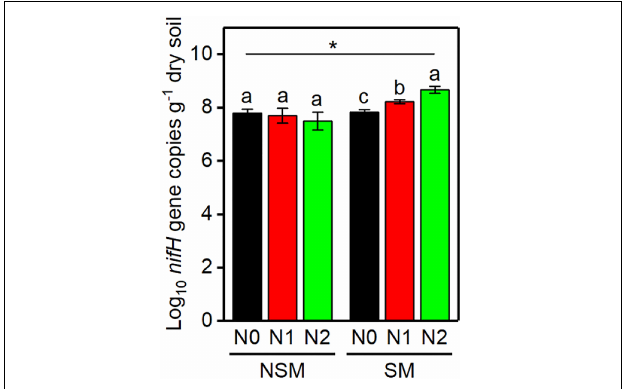
FIGURE 1 | The abundance of nifH gene copies in wheat rhizosphere soil under straw mulching and nitrogen fertilization treatments. NSM, no straw mulching; SM, straw mulching; N0, no nitrogen; N1, 120 kg N ha − 1 ; N2, 180 kg N ha − 1 . Data shown as mean ± SD. *indicates statistically significant difference ( P < 0.05) between NSM and SM. Different letters above columns indicate statistically significant difference ( P < 0.05) between N fertilizer levels within NSM and SM.